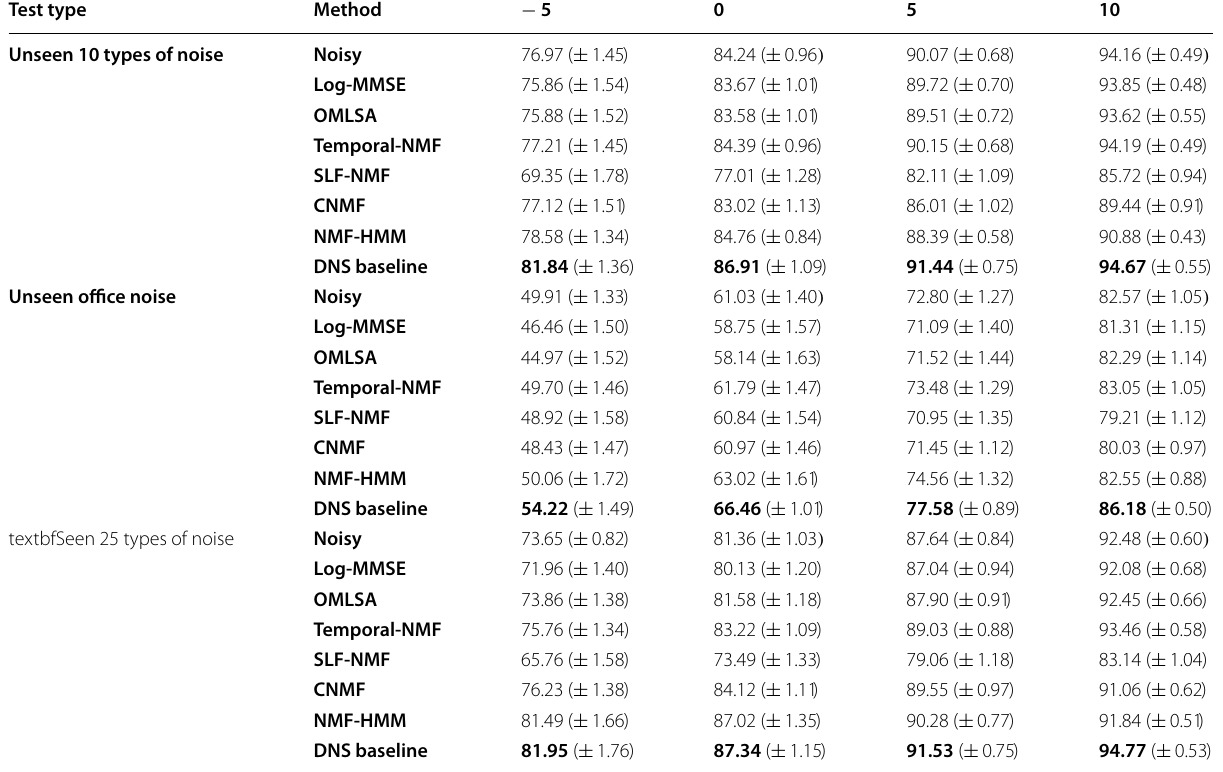
Table 5 Comparison of STOI scores (%) for various algorithms under different SNRs using different types of noise Test